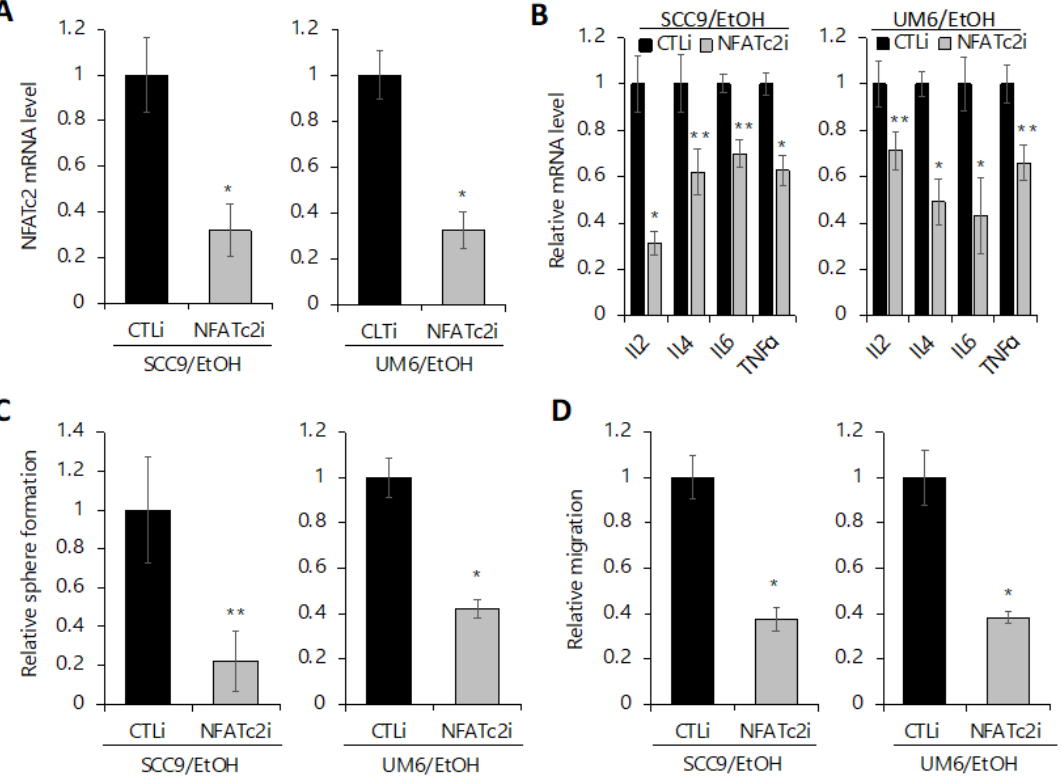
Figure 6. Knockdown of NFATc2 suppresses the stemness property of the EtOH-exposed OSCC. ( A ) NFATc2 in the EtOH-exposed OSCC cells (SCC9/EtOH and UM6/EtOH) was knocked down using siRNA against NFATc2 (NFATc2i). The cells transfected with control siRNA (CTLi) were in- cluded for comparison. NFATc2 knockdown was confirmed by qPCR. * p < 0.001 compared to CTLi- transfected controls by paired t test. ( B ) Effect of NFATc2 knockdown on the expression of NFAT downstream targets (IL2, IL4, IL6, and TNF α ) was determined by qPCR. * p < 0.001, ** p < 0.05. ( C ) Effect of NFATc2 knockdown on self-renewal capacity of the EtOH-exposed OSCC cells was deter- mined by tumor sphere formation assay. * p < 0.001, ** p < 0.05. ( D ) Effect of NFATc2 knockdown on migration capacity of the EtOH-exposed OSCC cells was determined by transwell migration as- say, respectively. * p < 0.001.